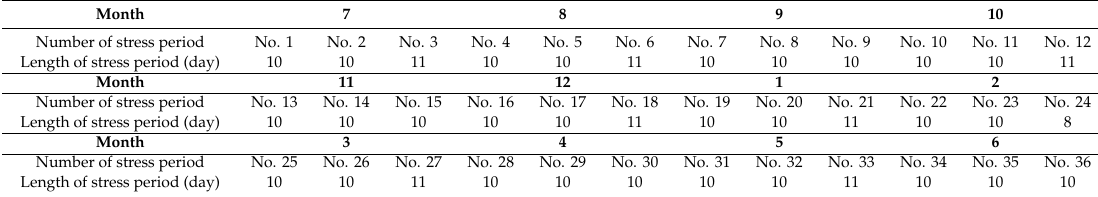
Table 2. Division of the stress periods in the groundwater flow model.